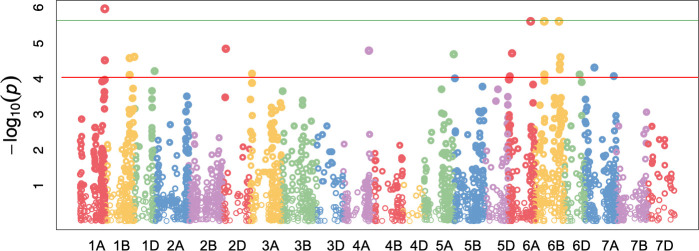
Manhattan plot showing significant SNP markers associated with RWA resistance using CMLM with a FDR adjusted p-value of 0.05.The horizontal green and red lines represent the threshold for genome wide significance (p < 0.000001) and FDR adjusted p < 0.0001, respectively.